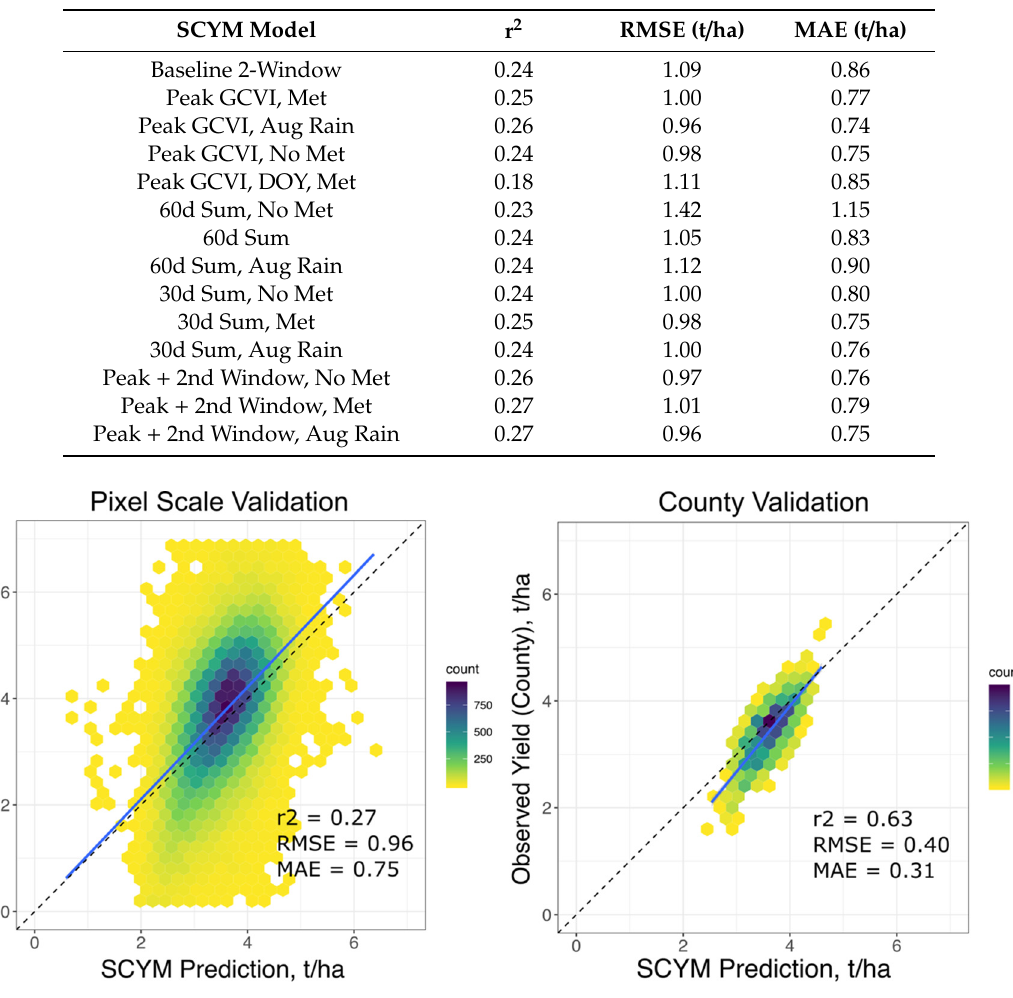
Figure 6. SCYM Performance at the Pixel and County Scale. Figure displays SCYM performance against pixel- and county-scale validation yields, across 2008–2018. Data are shown for the same county-years which were held out from model selection. County validation, at right, is shown based on averaged predictions across all soybean CDL pixels for that year, not just fields for which we had harvester data. RMSE and MAE are reported in t /